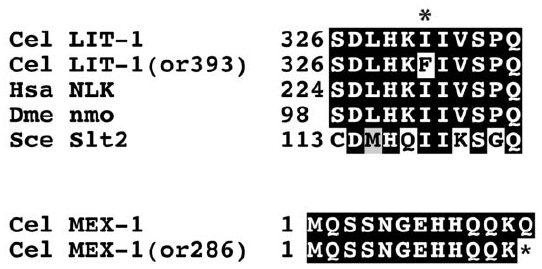
Figure 10. Sequence alterations in the lit-1(or393 ts ) and mex- 1(or286 ts ) mutants. Amino acid alterations in the mutants. Asterisks indicates changed residues. Homologous proteins are aligned below the C. elegans protein for LIT-1. A glutamine codon was changed to a stop codon in the mex-1(or286 ts ) allele.